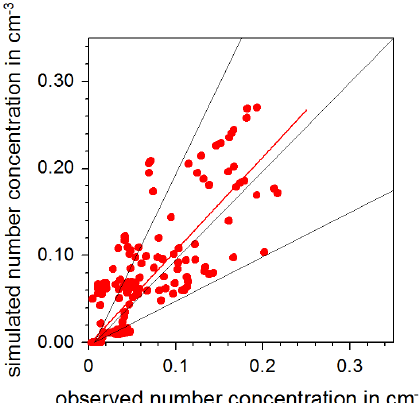
Figure 7. Simulated and observed number concentrations for the model runs shown in Fig. 6b. The red curve shows the calculated regression line. The correlation coefficient is